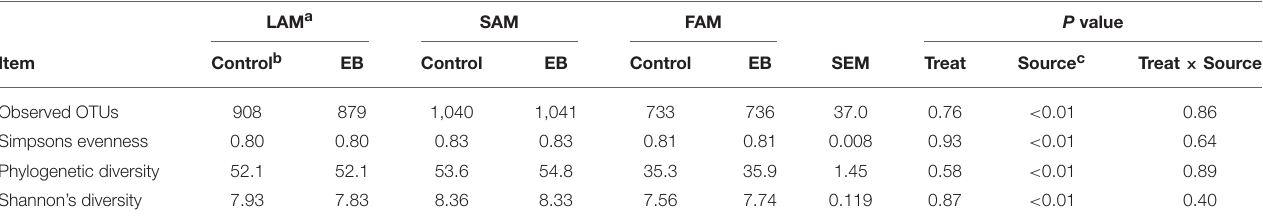
TABLE 9 | α -diversity indices of liquid-(LAM), solid-(SAM) and fecal-(FAM) associated microbes of beef heifers fed a barley silage-based diet containing 2.0% enhanced biochar (EB; n = 8 per treatment). LAM a SAM FAM P value Item Control b EB Control EB Control EB SEM Treat Source c Treat × Source Observed OTUs 908 Phylogenetic diversity